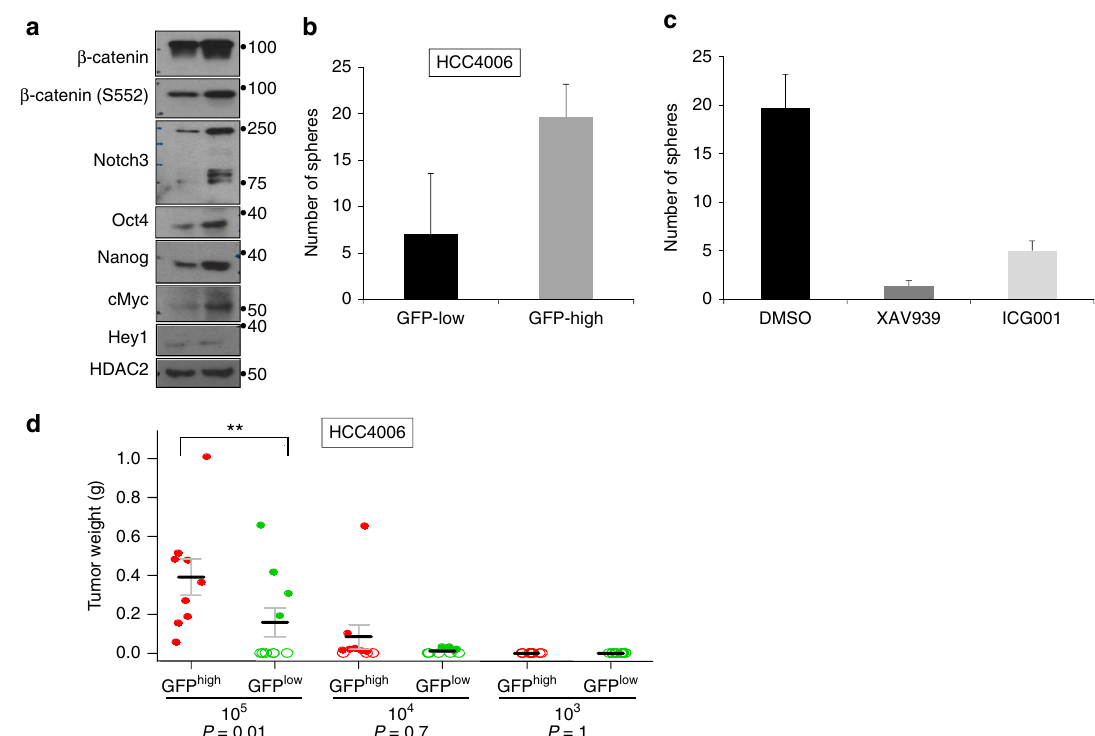
Fig. 5 EGFR TKI treatment activates β -catenin signaling, which is responsible for the maintenance of DPCs. a HCC4006-Tcf/Lef-GFP reporter cells were treated with 0.1 μ M erlotinib for 6 days and sorted for GFP expression by FACS into GFP high (high β -catenin activity) and GFP low (low β -catenin activity) cell populations, which were subsequently analyzed for Notch3, β -catenin, and stem cell markers by WB. b GFP high and GFP low cell populations were subjected to sphere formation assay. Quanti fi cation of total number of pulmospheres from both groups is shown. c EGFR TKI persistent pulmospheres are sensitive to β -catenin pathway inhibitors. HCC4006 cells were treated with erlotinib and TCF-GFP reporter positive cells were subjected to pulmosphere assay in the presence of DMSO or β -catenin inhibitors, XAV939, ICG-001. Quanti fi cation of total number of pulmospheres from all experimental conditions. d HCC4006-Tcf/Lef-GFP reporter cells were treated with 0.1 μ M erlotinib for 6 days and cells with high and low GFP reporter activities were isolated by fl ow sorting. A limiting dilution assay was performed by injecting NSG mice with the number of GFP high and GFP low cells indicated. After 8 weeks the tumors were excised and tumor volumes and weights were measured. Solid- fi lled circles indicate individual tumor weights and open circles indicate no tumor grew at the site of injection. Red circles represent the group of tumors that were obtained by injection of GFP high HCC4006 cells. Green circles represent group of tumors that were obtained by injection of GFP low HCC4006 cells. Linear model was used to compare GFP high and GFP low groups within each group of cell dilution level. P values were adjusted for multiple comparisons by Holm ’ s procedure. For ( b ) and ( c ) error bars represent SD